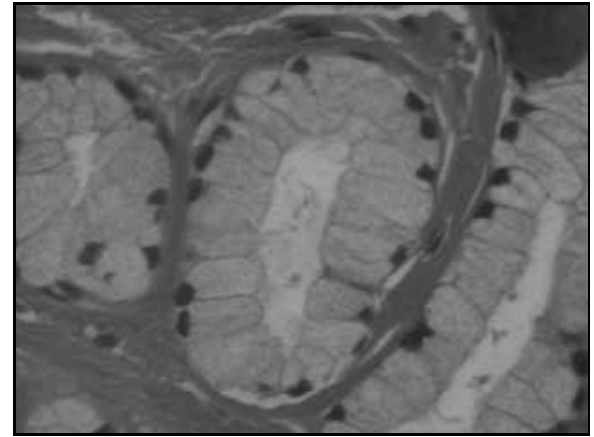
Figure 1 – Nodular hyperplasia’s margin showing nonencapsuled and slightly irregular contour (HE, magnification 40×) HE: hematoxylin and eosin.